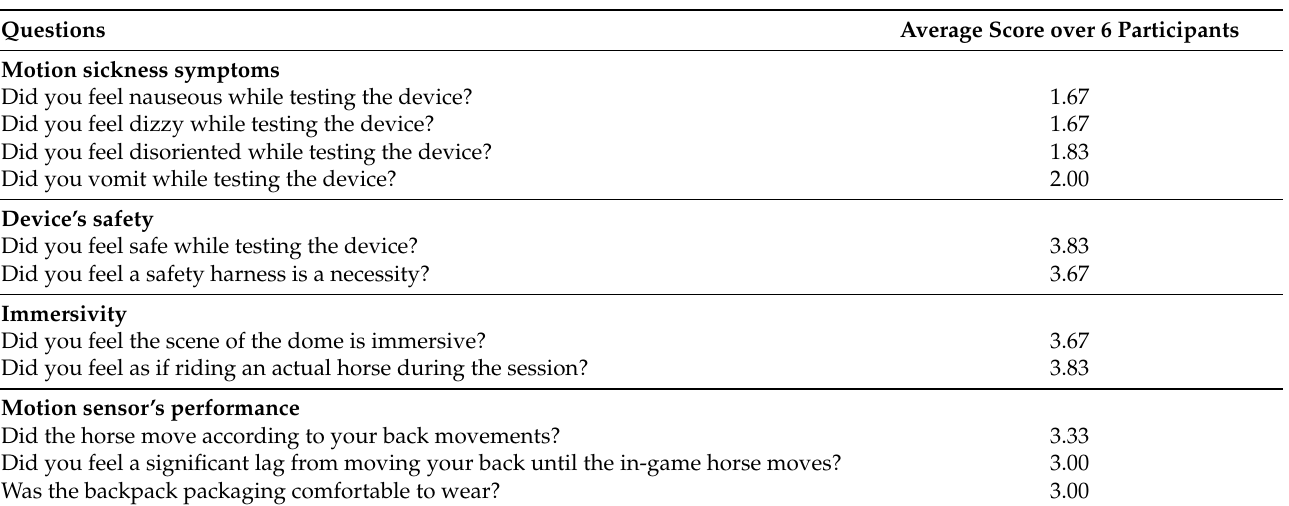
Table 3. Subjective evaluation from the participants (1 = strongly disagree, 2 = disagree, 3 = neutral, 4 = agree, 5 = strongly